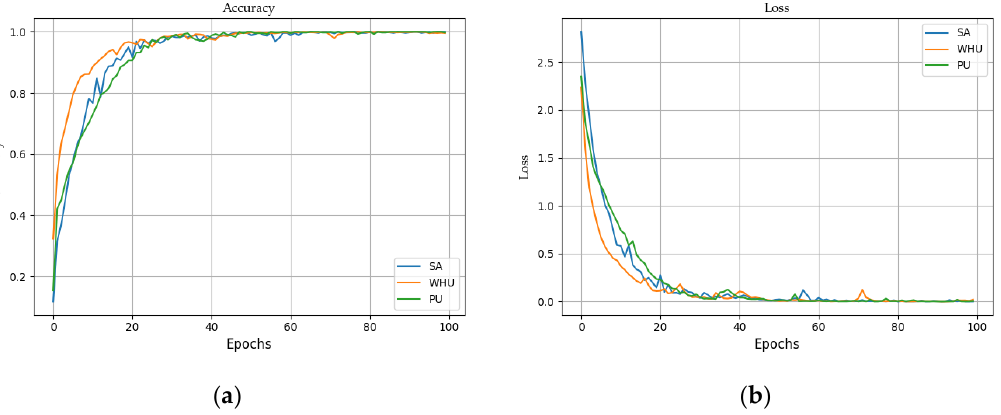
Figure 7. The confusion matrices of MDAN in the three selected datasets: ( a ) the confusion of the SA dataset; ( b ) the confusion of the WHU dataset; ( c ) the confusion of the PU dataset.